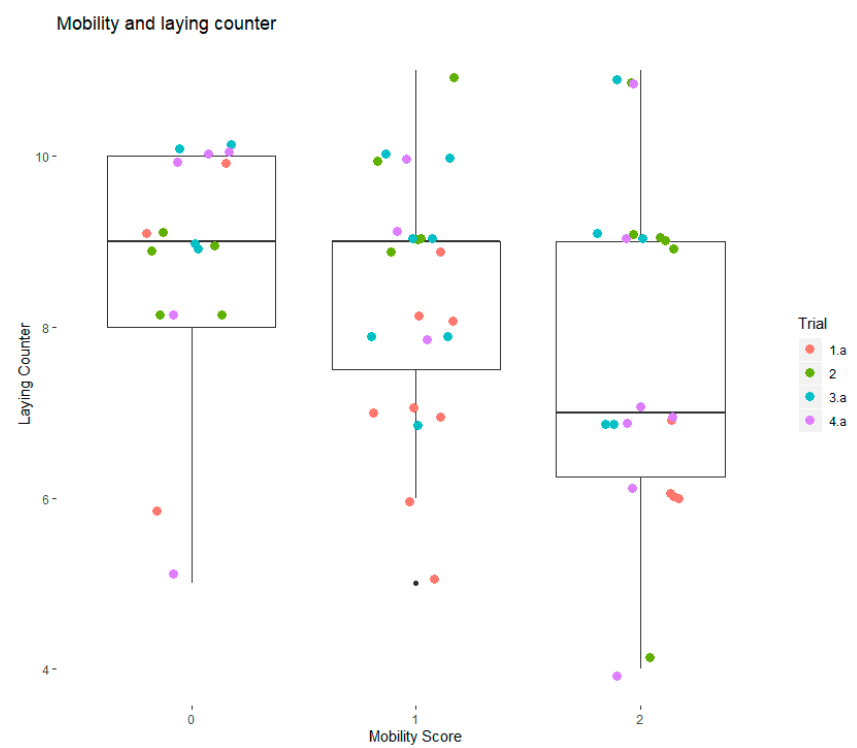
Figure 1. Laying counter (n / d) and mobility score for the aggregated dataset A. Laying counter is the number of times a day in which the pedometer was in a horizontal position for more than 50